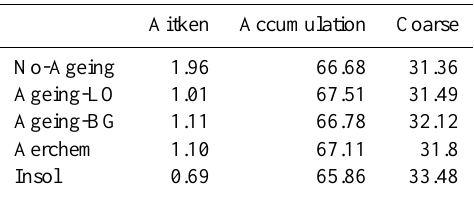
Table 2. Mass weighted contributions (in %) of the individual hy- drophilic modes to the aerosol water attached to the organic aerosol